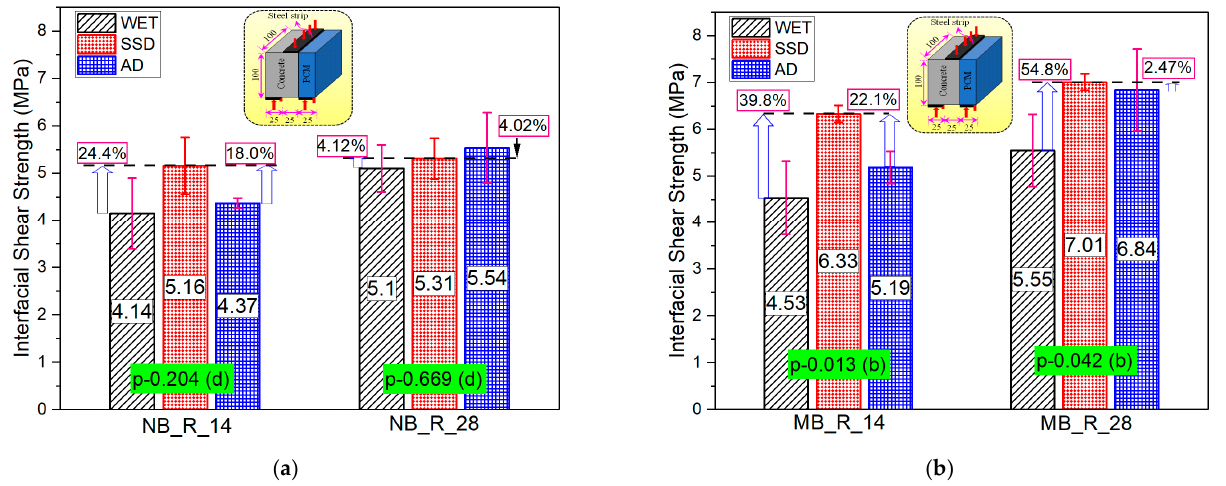
Figure 16. The influence of different moisture states on the bond strength of the interface. ( a ) Normal PCM, ( b ) modified 5% silica PCM. PCM, ( b ) modified 5% silica Table 8. A typical example of calculation and analysis of the relativity of the impact factors.